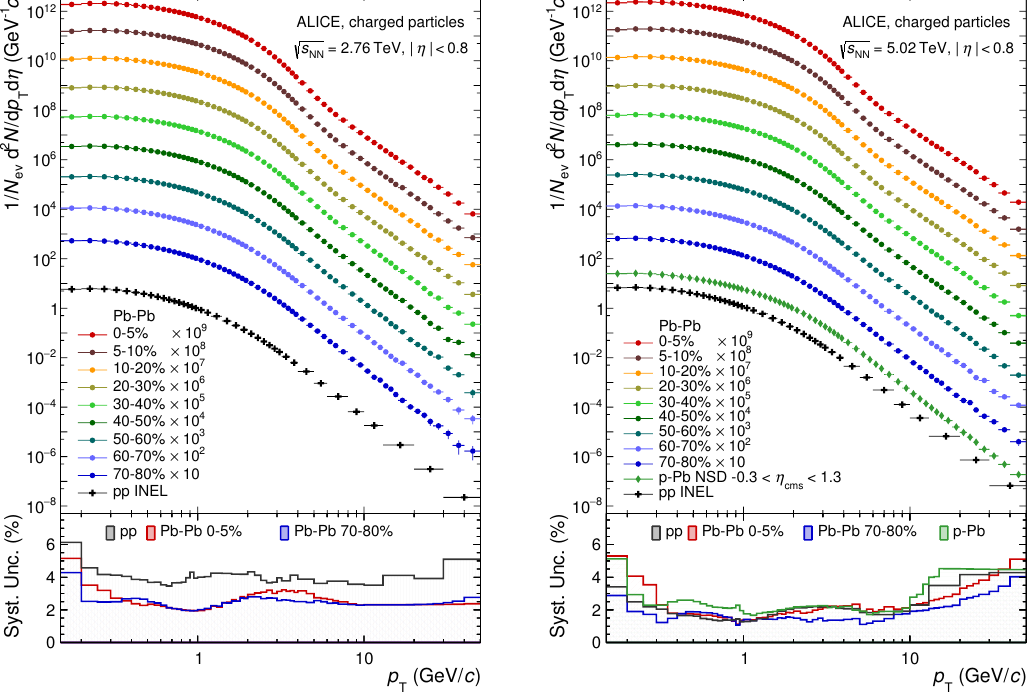
Figure 3 . Transverse momentum distributions of primary charged particles in j (cid:17) j < 0 : 8 in nine p centrality intervals in Pb-Pb collisions at s NN = 2.76 (left) and 5.02 TeV (right) (scale factors as indicated are used for better visibility). The data for pp collisions, obtained scaling the cross p section by (cid:27) NN , and NSD p-Pb at s NN = 5 : 02 TeV are also shown. The relative systematic un- inel certainties are shown in the lower panels for various datasets; these do not contain the normalization